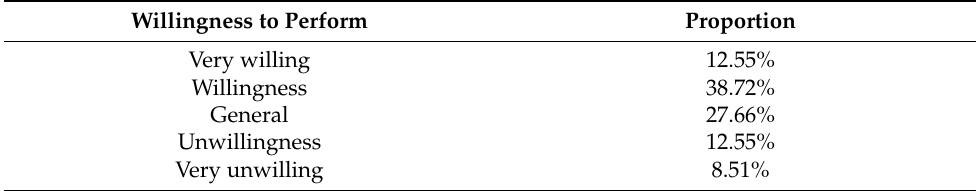
Table 7. The willingness of farmers to implement the policy of “coal to